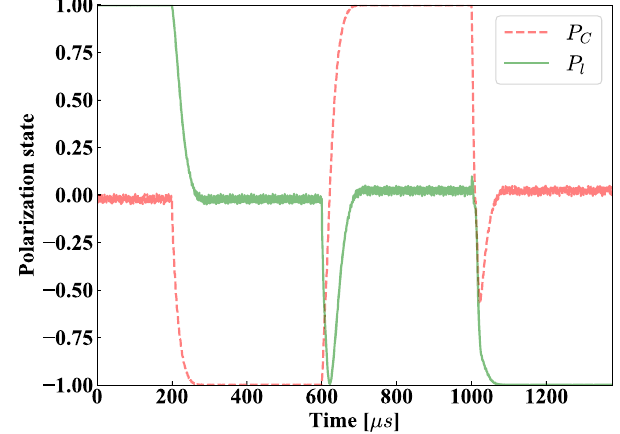
FIG. 7. The evolution of the polarization state. P c displays by red dash line and P l displays by the green line. After changing the phase shifter, phase difference becomes stable within about 50 passes for different polarized states.